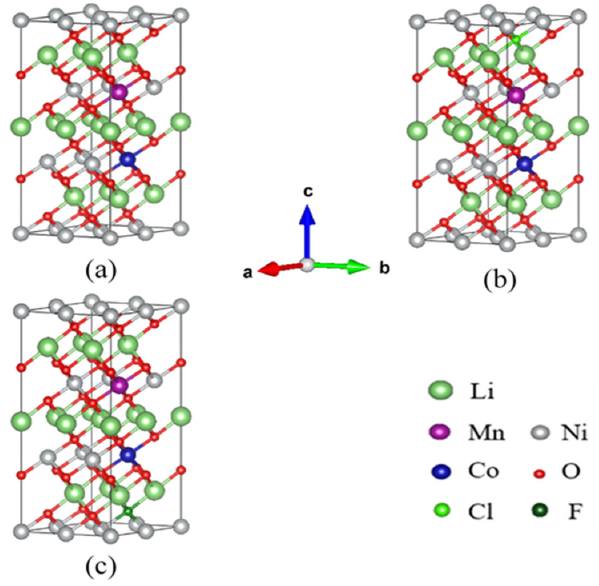
Figure 3. Cell structure diagram: ( a ) NCM811 ‐ Intermediates, ( b ) NCM811 ‐ Intermediates ‐ Cl, ( c ) NCM811 ‐ Intermediates ‐ F.